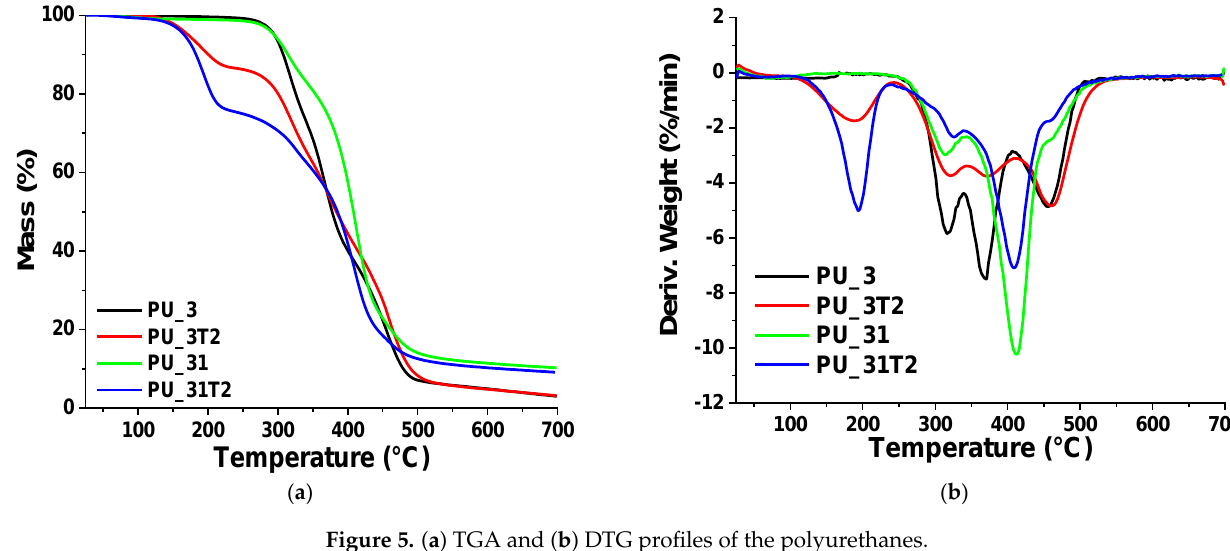
Figure 5. ( a ) TGA and ( b ) DTG profiles of the polyurethanes.